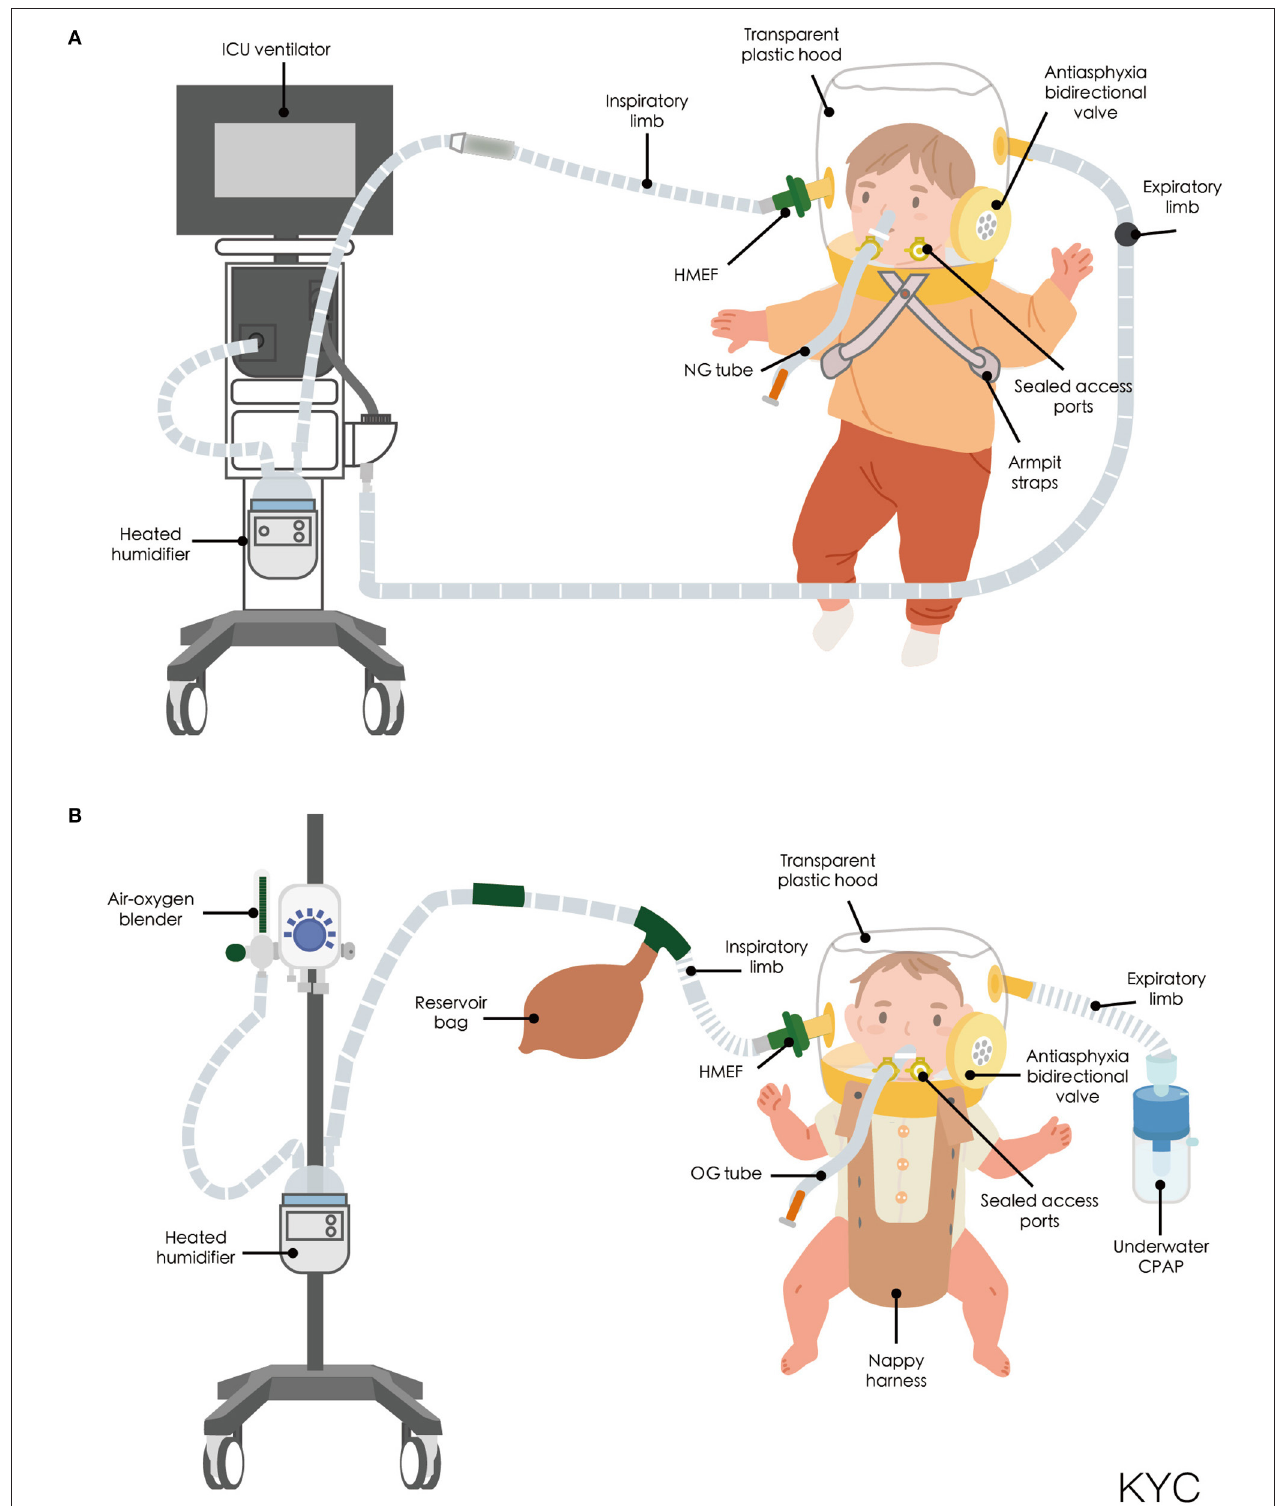
FIGURE 1 | (A) Schematic of helmet connected to a ICU ventilator. (B) Schematic of helmet connected to a high-flow generator with an underwater positive end-expiratory pressure system. CPAP, continuous positive airway pressure; HMEF, Heat and moisture exchanging filter; ICU, intensive care unit; NG tube, nasogastric tube; OG tube, Orogastric